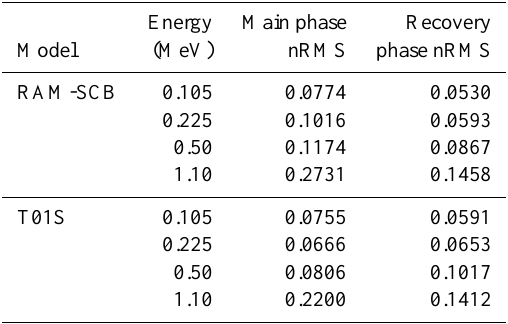
Table 1. The normalized root-mean-square (nRMS) errors for the flux comparison during the main phase and recovery phase. A smaller nRMS error means a better flux prediction from the data